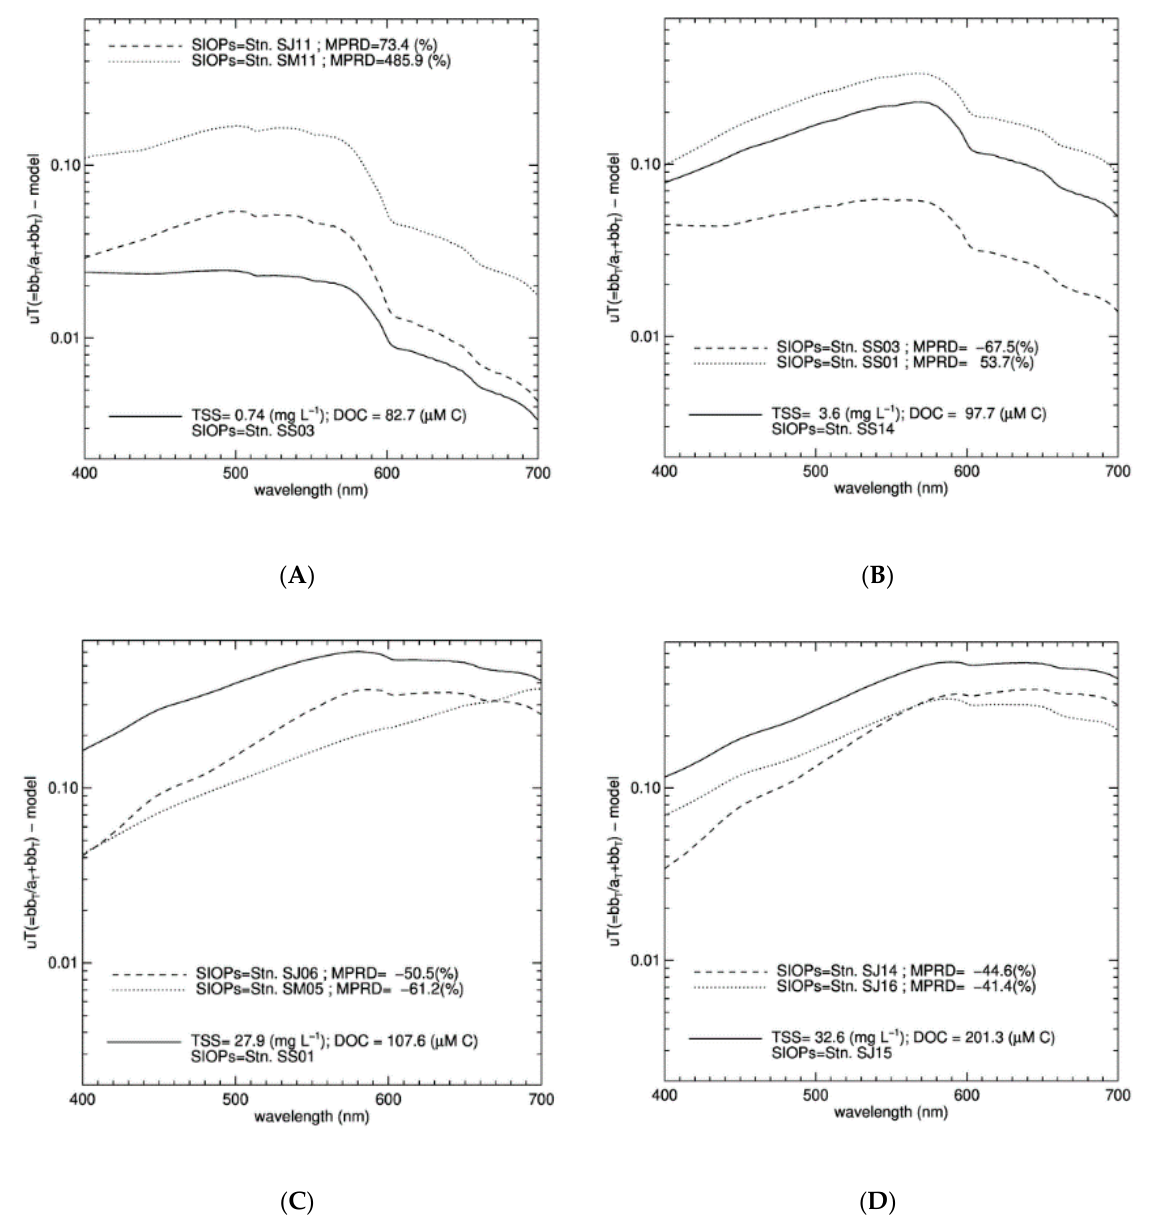
Figure 9. Model simulations show the limitation of extrapolating optical properties in Sarawak coastal waters. ( A ) comparison of optical spectra in relatively clear waters with higher values in the blue-green region, ( B ) comparison of optical spectra in coastal waters with a maximum in the green region of the spectrum, ( C ) comparison of optical spectra in turbid coastal waters with higher values in the green-red region of the spectrum, and ( D ) variability in optical spectral shape and magnitude due to varying SIOPS in response to changing salinity (river discharges).